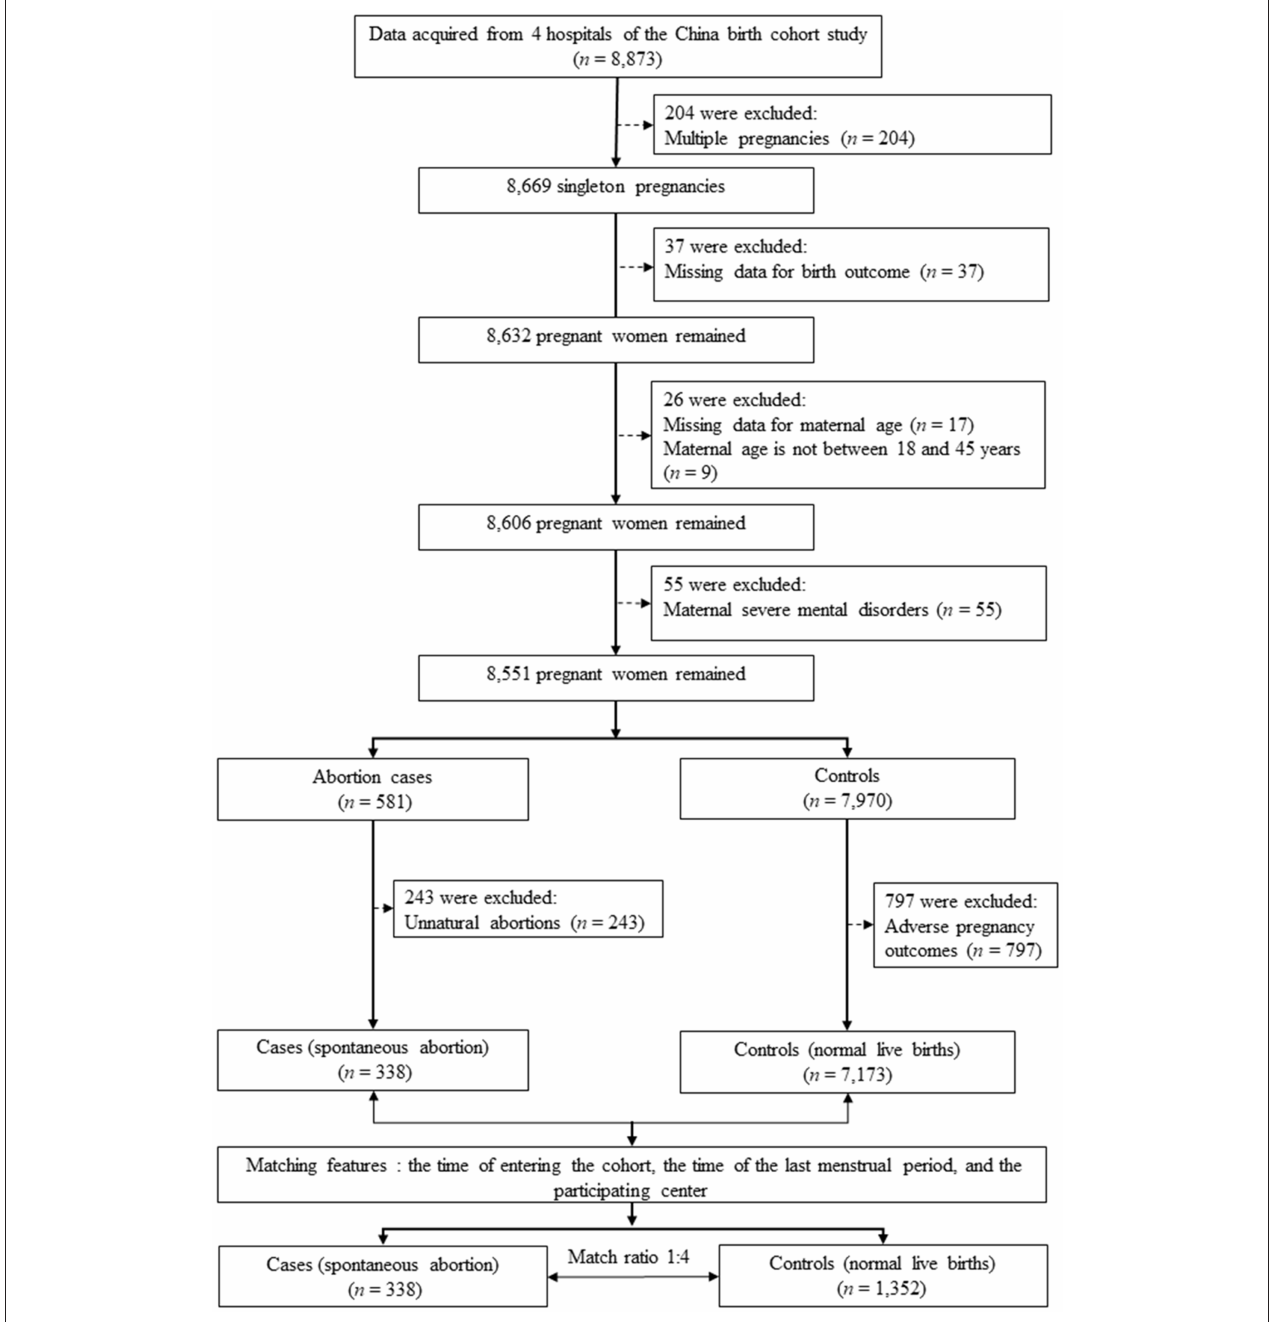
FIGURE 1 | Flow chart of study participants selection.